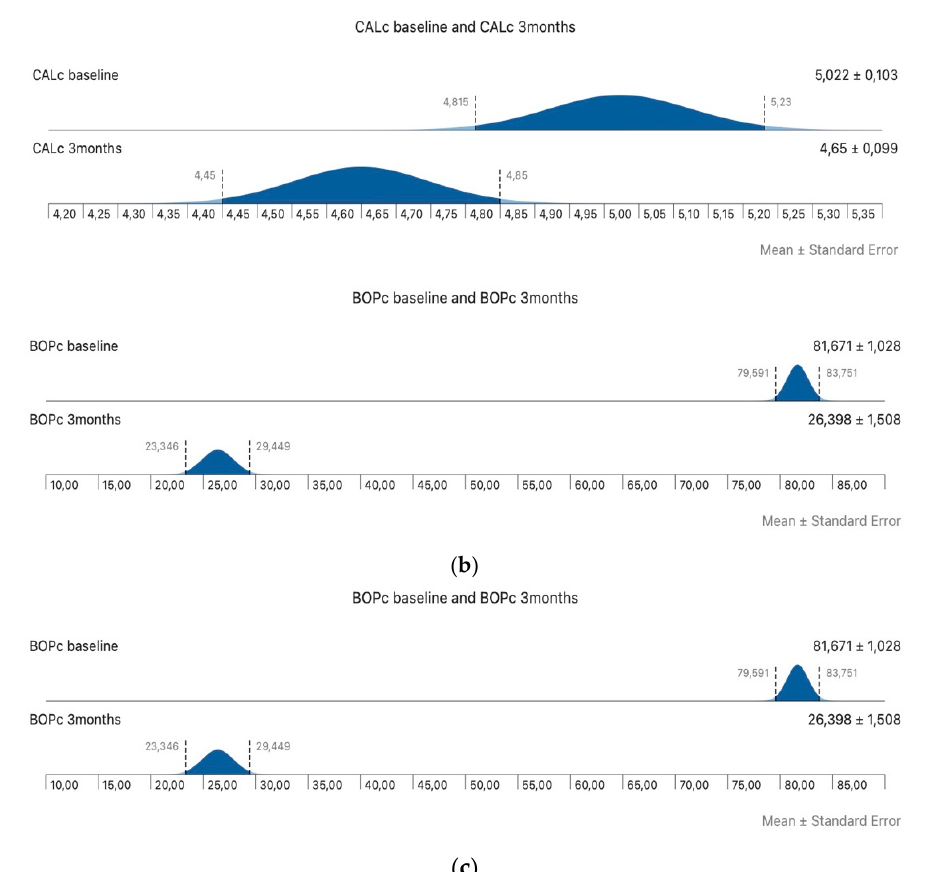
Figure 2. Comparaison at baseline and 3 months in control group between ( a ) probing depth val ‐ ues (PDc: probing depth in SRP alone sites); ( b ) clinical attachment loss (CALc: clinical attachment loss in SRP alone sites); ( c ) bleeding on probing values (expressed in %) (BOPc: bleeding on prob ‐ ing in SRP alone sites).